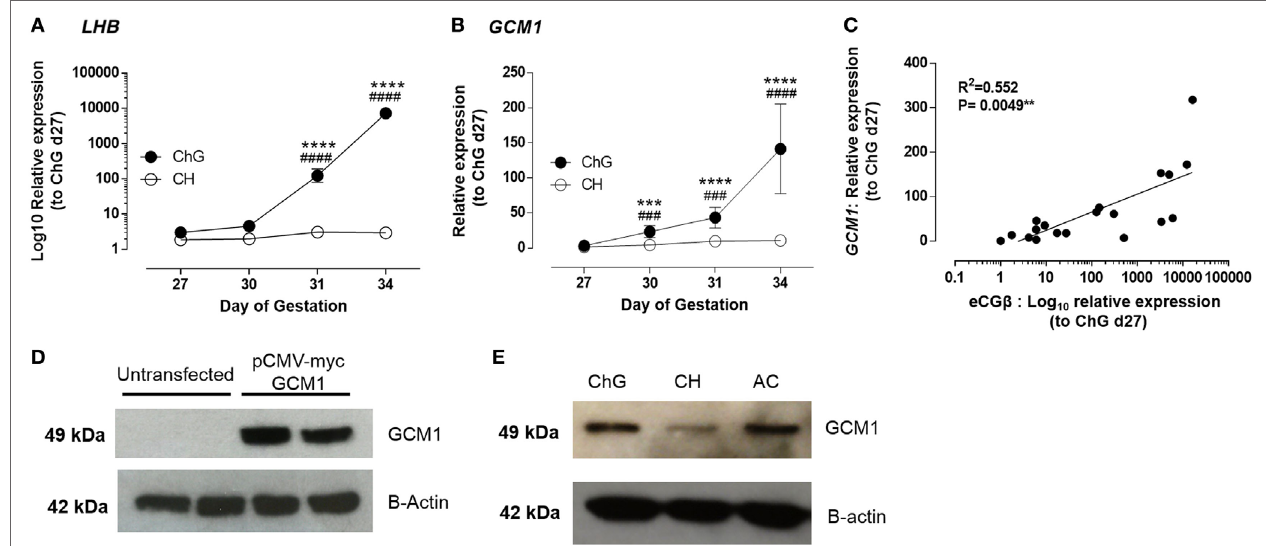
FigUre 1 | GCM1 is expressed in equine trophoblast and expression correlates with LHB . (a) mRNA expression of LHB in ChG and chorion tissues at days 27, 30, 31, and 34 of pregnancy. (B) mRNA expression of GCM1 in ChG and chorion tissues at days 27, 30, 31, and 34 of pregnancy. (c) Correlation of mRNA expression of LHB and GCM1 in individual ChG tissues. *** p < 0.001, **** p < 0.0001 relative to day 27 ChG, ### p < 0.001, #### p < 0.0001 relative to CH at same time point (linear mixed-effects modeling, SPSS). (D) Glial cells missing 1 (GCM1) protein expression in untransfected COS7 cells and COS7 cells transfected with 250 ng of equine pCMV-myc-GCM1 expression vector. B-Actin expression was used as a loading control. (e) GCM1 and B-Actin protein expression in primary equine day 34 conceptus tissues: chorionic girdle (ChG), chorion (CH), allantochorion (ALC), and yolk sac